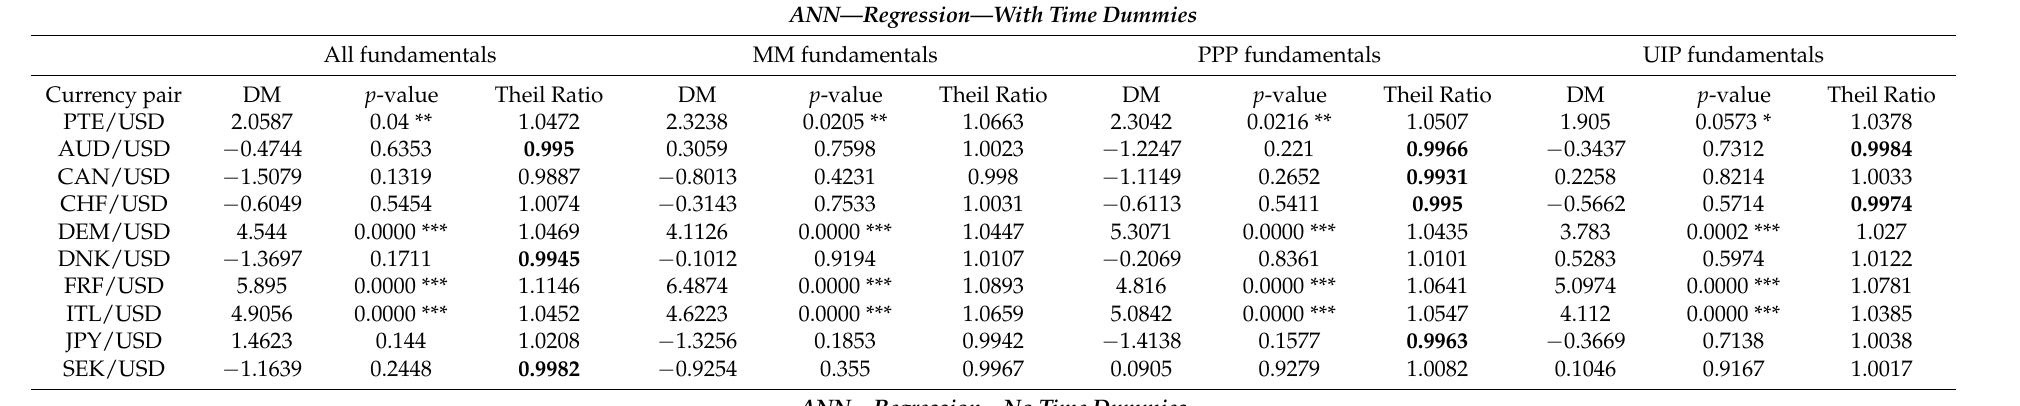
Table 2. One-month-ahead forecasting of exchange rate differentials with fundamentals using ANN. ANN—Regression—With Time